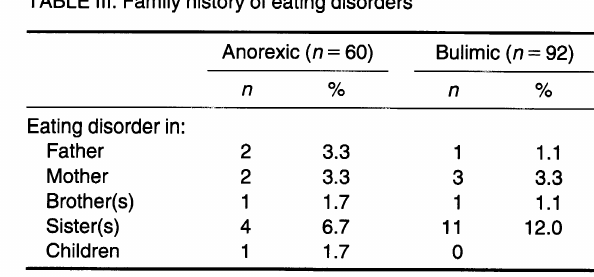
TABLE III. Family history of eating